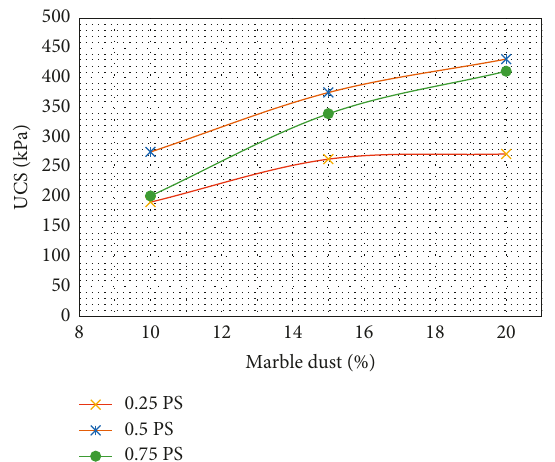
Figure 8: UCS value variations with percentages of marble dust and plastic